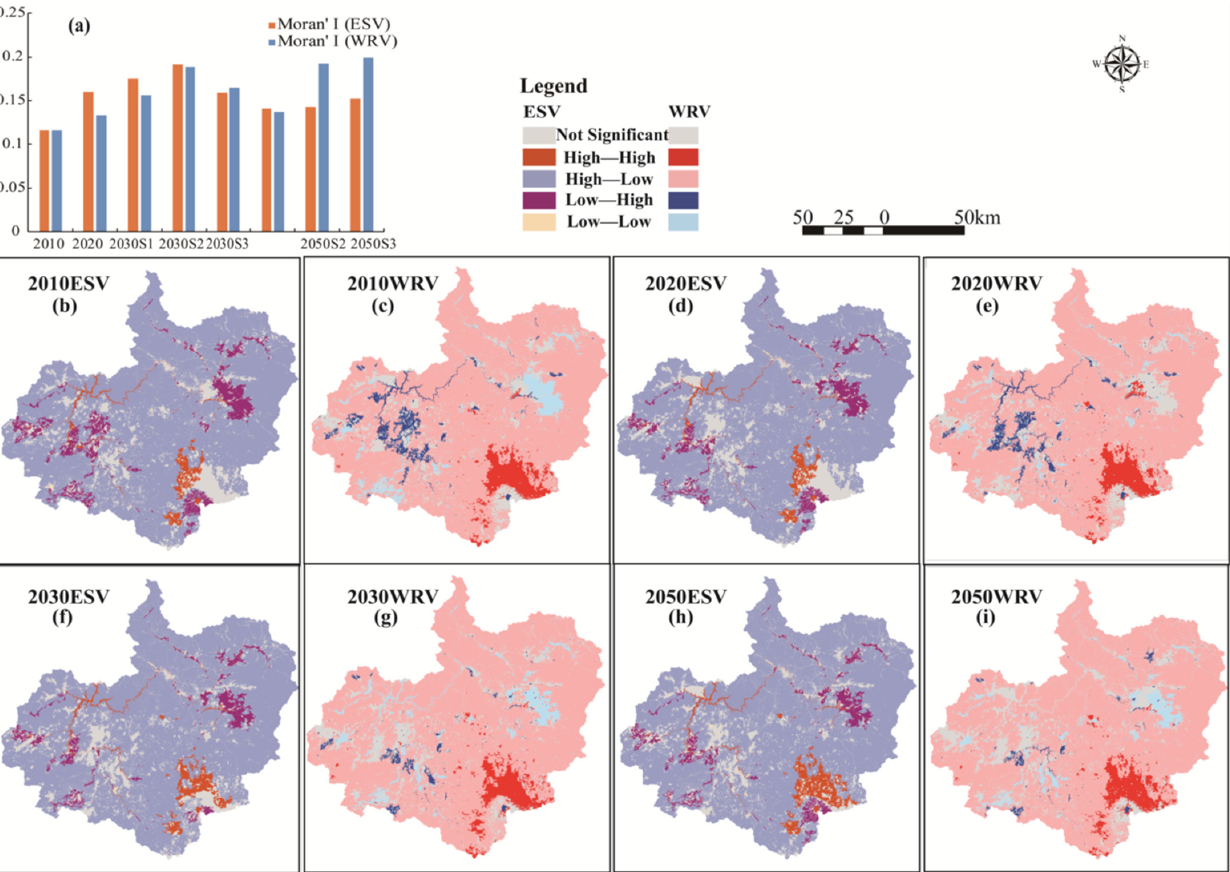
Figure 8. Spatial autocorrelation analysis of ESV and WRV from 2010 to 2050 of WRS scenario: ( a ) is the Moran’s I change diagram and ( b , d , f , h ) are the LISA maps of ESV; ( c , e , g , i ) are the LISA maps of WRV.